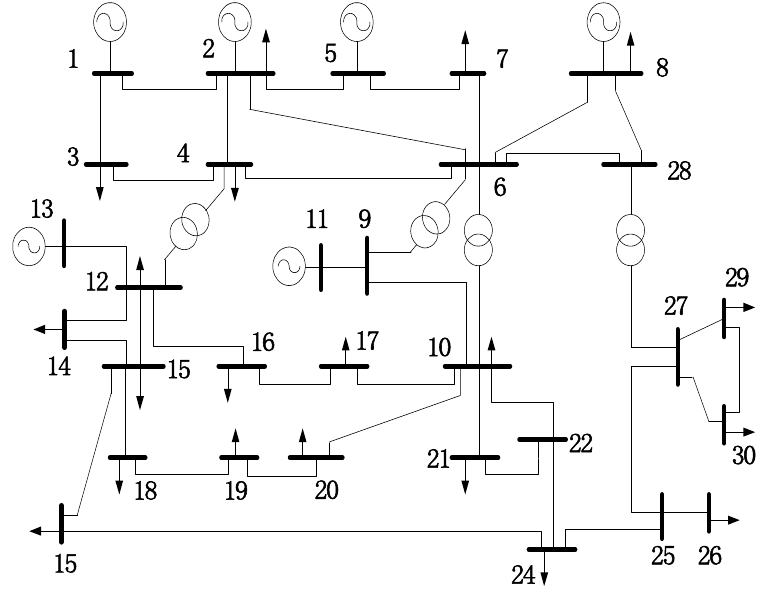
Figure 5. Structure of modified IEEE-30 bus system.